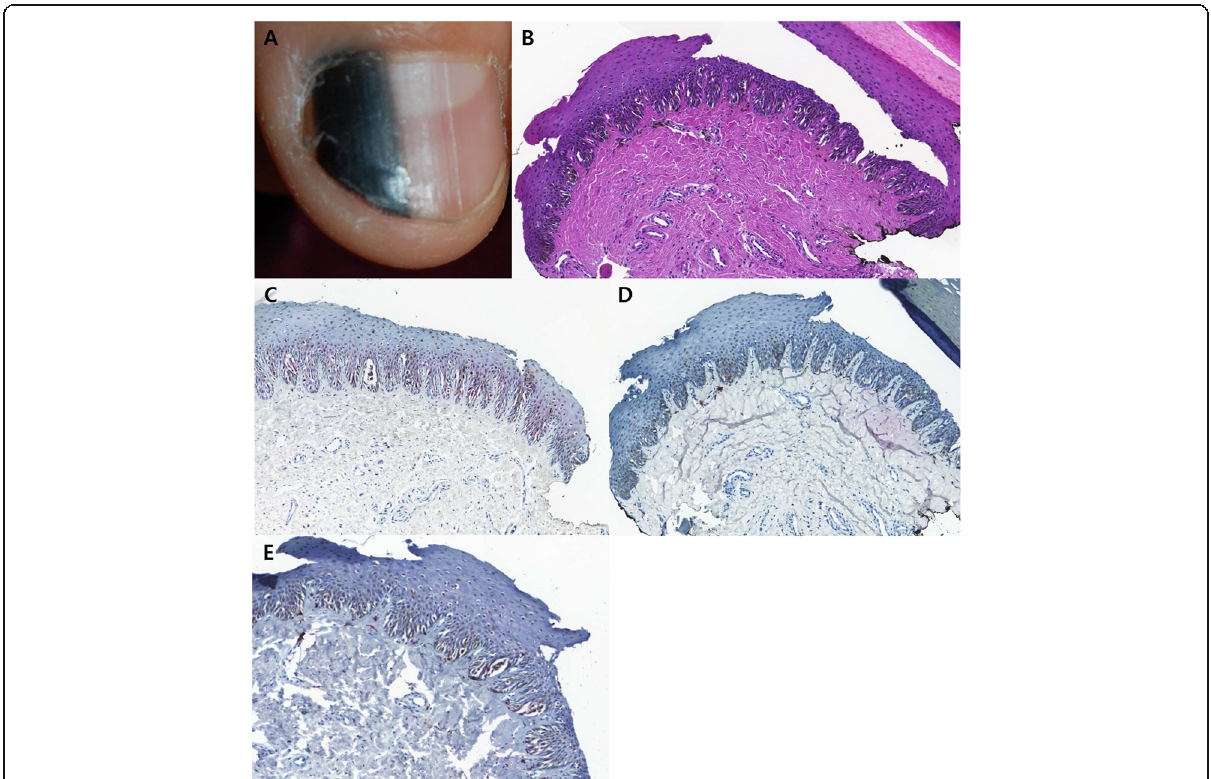
Fig. 1 Representative clinical morphology, photomicrographs of H&E staining, and IHC staining for cyclin D1and PRAME of selected subungual benign melanocytic proliferation. One 7-year-old patient presenting with ( A ) 3.5 mm-wide melanonychia showed ( B ) melanocyte proliferation showing mild atypia without confluency or pagetoid spread (200x magnification, H&E). ( C ) While cyclin D1 IHC showed over 70% nuclear immunostaining (200x magnification), ( D ) PRAME IHC exhibited total negativity (200x magnification), ( E ) Sox-10 IHC (200x